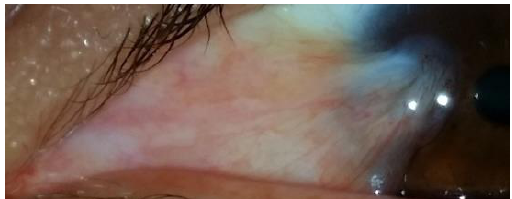
Figure 1. The predominance of pterygium on the nasal side is thought to be predominantly due to focusing of the sun rays onto this